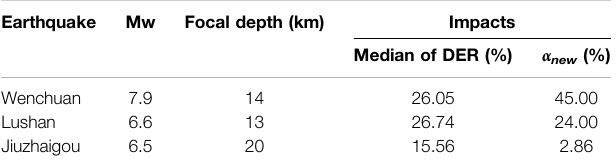
TABLE 2 | Earthquake attributes and their impacts on regional rainfall thresholds.